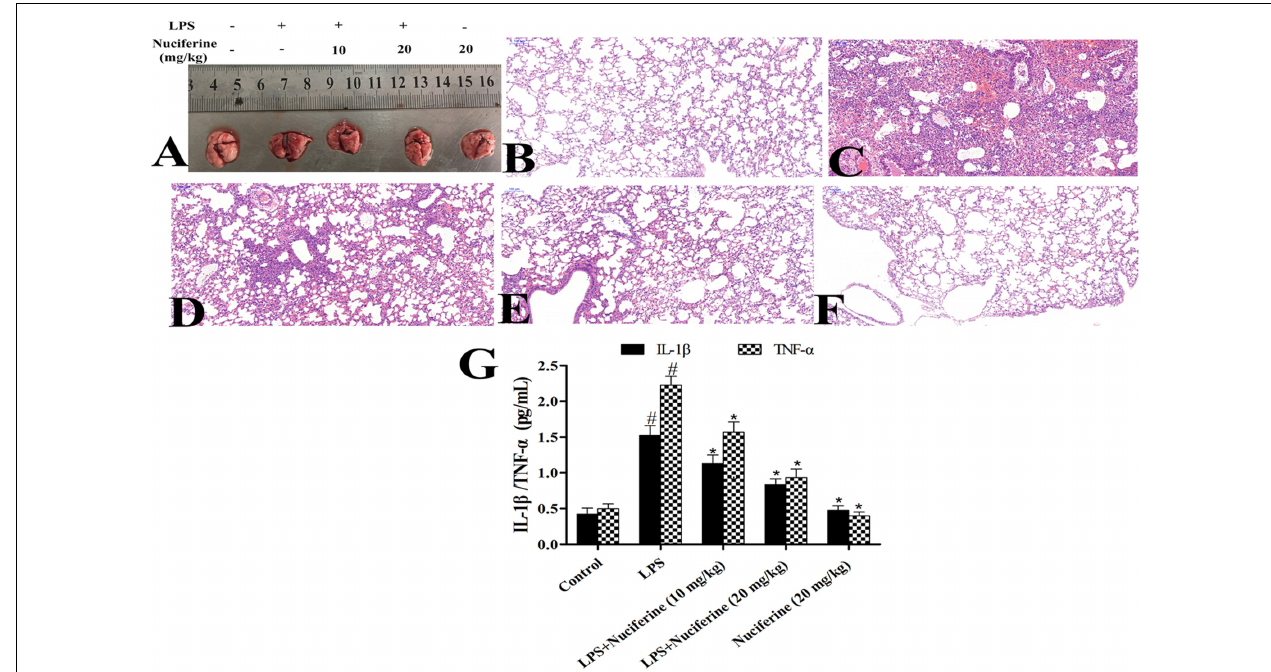
FIGURE 2 | Effects of nuciferine on lipopolysaccharide (LPS)-induced lung injury. (A) Morphology of the lung. (B) Control group. (C) LPS group. (D,E) LPS + nuciferine (10 and 20 mg/kg) groups. (F) Nuciferine (20 mg/kg) group. (G) Bronchoalveolar lavage fluid was determined with an ELISA kit. Data are represented as the mean ± SEM of three independent experiments. # p < 0.05 vs. Control group, ∗ p < 0.05 vs. LPS group.